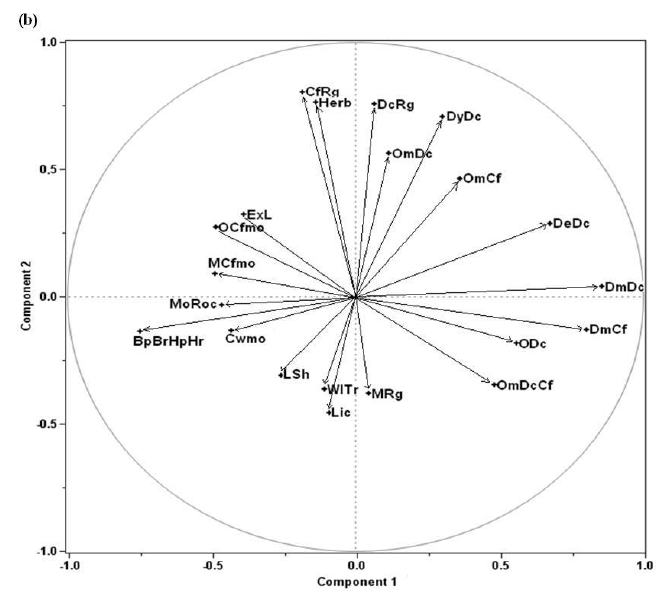
Figure 4. PCA showing successional pathways of post-disturbance land cover types of fire events and harvested agglomerations. Each land cover type is described using its relative proportion within the disturbed area. ( a ) Disturbance scores (fire events and harvested agglomerations). The digit represents the TSD (time since disturbance). The fire events (in bold) with pre-burned mature forest covers >40%. ( b ) Loadings of land cover types. CfRg (coniferous regeneration), Herb (perennial crops, pasture, fallow, grassland), DcRg (deciduous regeneration), DyDc (dense young deciduous), OmDc (open mixed deciduous tendency), Exl (exposed land), OCfmo (open coniferous with moss), DeDc (dense deciduous), MCfmo (medium coniferous cover with moss), DmDc (dense mixed deciduous tendency), MoRoc (moss and rock), BpBrHpHr (burn, post-burn regeneration, harvest, and post-harvest regeneration), Cwmo (coniferous woodland with moss), DmCf (dense mixed deciduous with coniferous tendency), ODc (open deciduous), DmCf (dense mixed deciduous with coniferous tendency), OmDcCf (open mixed deciduous and coniferous tendency), LSh (low shrubs), WlTr (wetland with tall shrubs and trees), MRg (mixed regeneration), Lic